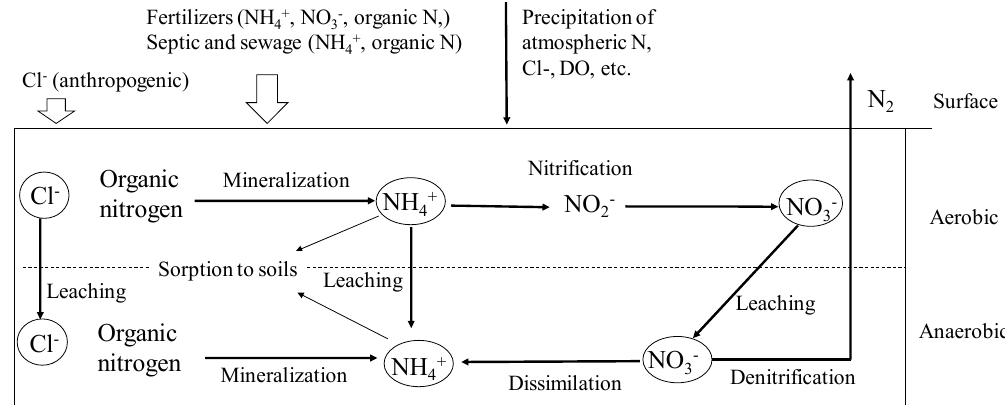
Figure 6. Schematic diagram of Cl − leaching and Nitrogen dynamics under sub-surface.